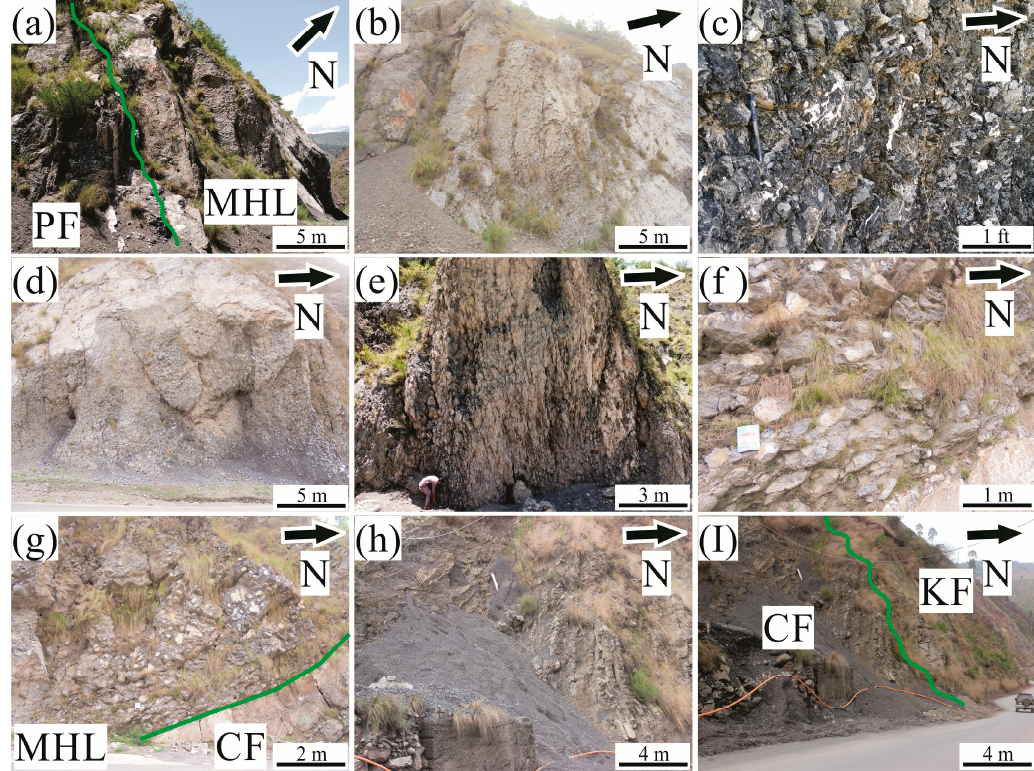
Figure 4. Photomicrographs showing ( a ) lower erosional unconformable contact of Patala Formation (PF) and Margalla Hill Limestone (MHL); ( b ) second nodular lithofacies; ( c ) calcite veins in third lithofacies; ( d ) carbonaceous material in third lithofacies; ( e ) massive nodular lithofacies; ( f ) nodular limestone; ( g ) contact between fifth and sixth lithofacies; ( h ) limestone and shale alteration lithofacies; and ( I ) upper erosional contact between Chorgali Formation (CF) and Kuldana Formation (KF).